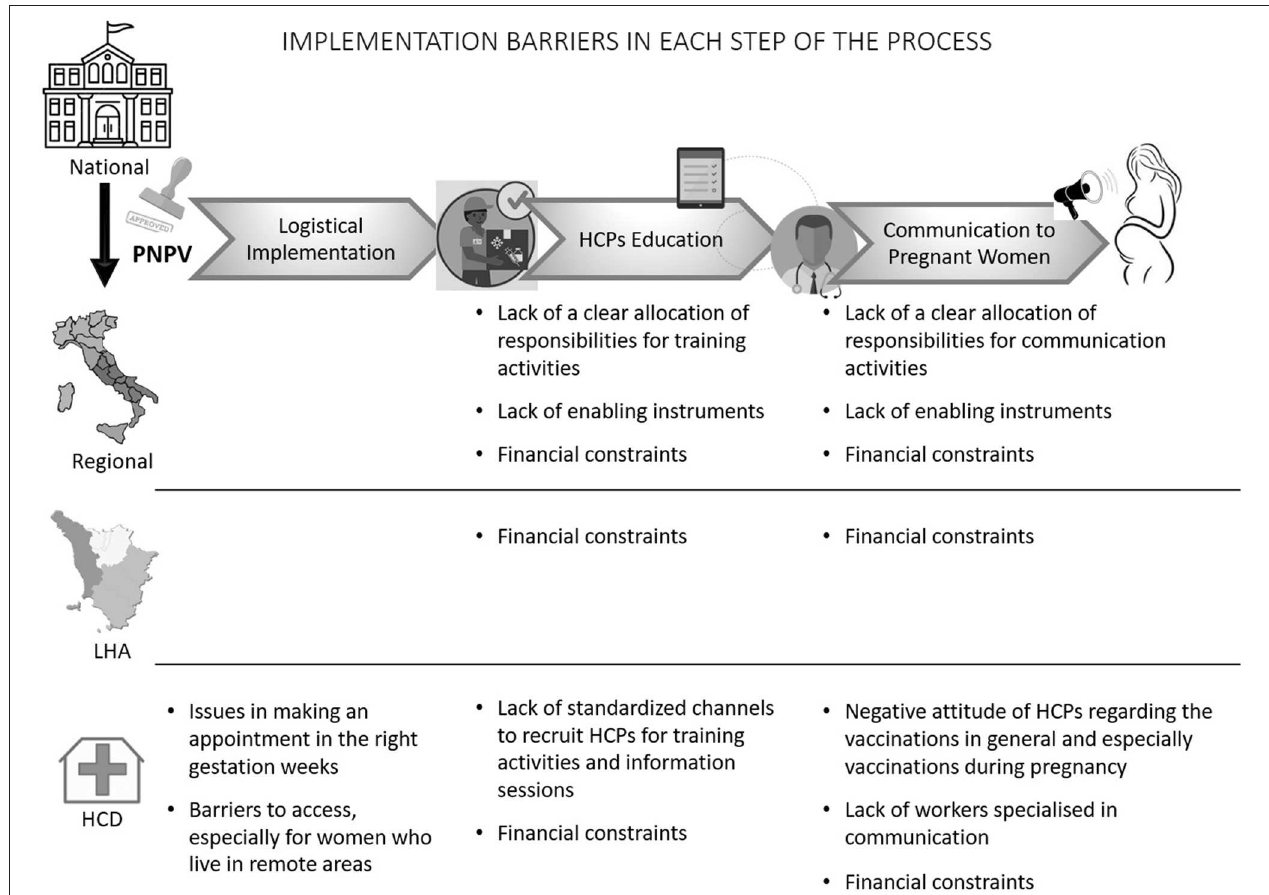
FIGURE 2 | Implementation barriers in each step of the